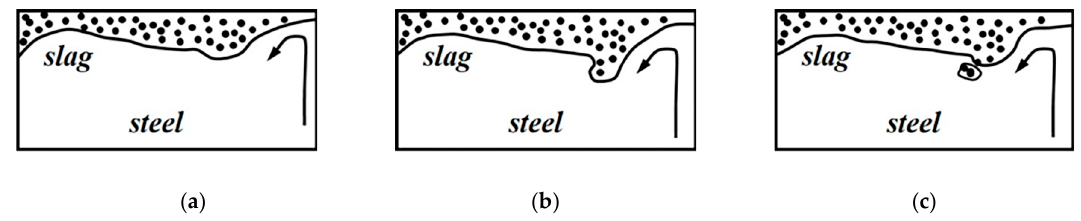
Figure 1. Slag entrapment by shear–layer instability: ( a ) flow upward after stream striking narrow face, ( b ) shearing effect on slag layer, ( c ) formation of slag droplet.